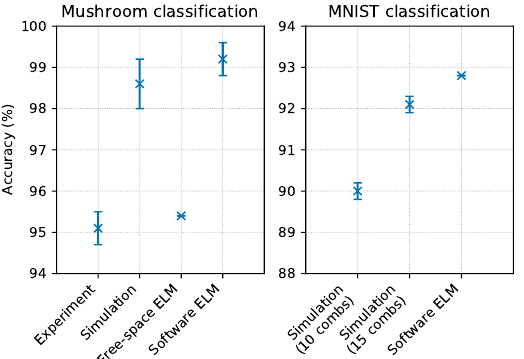
Figure 4. Results of single operation mode tests. The left panel contains results from the mushroom classification task. We report experimental results compared with the numerical simulation of our system, the score obtained by another photonic ELM reported in [8], and a software ELM with a number of neurons comparable to our experiment. The right panel contains results from the MNIST classification task. We report the results obtained by a numerical simulation featuring 10 combs ( ∼ 300 neurons), a numerical simulation featuring 15 combs ( ∼ 450 neurons), and a software ELM reported in [32] ( ∼ 800 neurons). When present, error bars represent the standard deviation of the score over 100 random repartitions of training and testing data (more information in Section